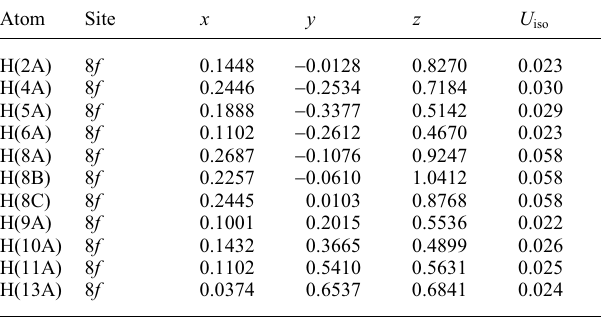
Table 2. Atomic coordinates and displacement parameters (in Å 2 )